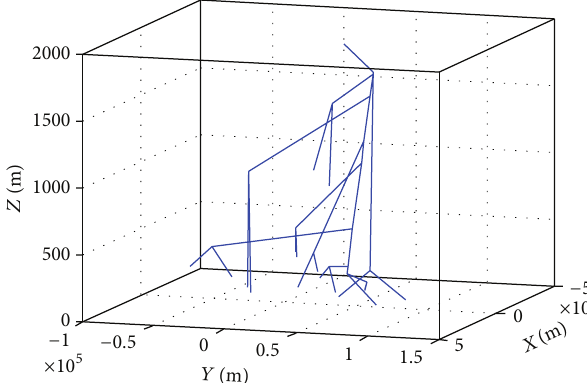
Figure 17: Semireal shape of lightning path, including some branches.